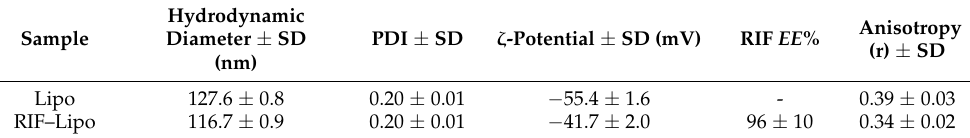
Table 2. Physicochemical features of liposomal